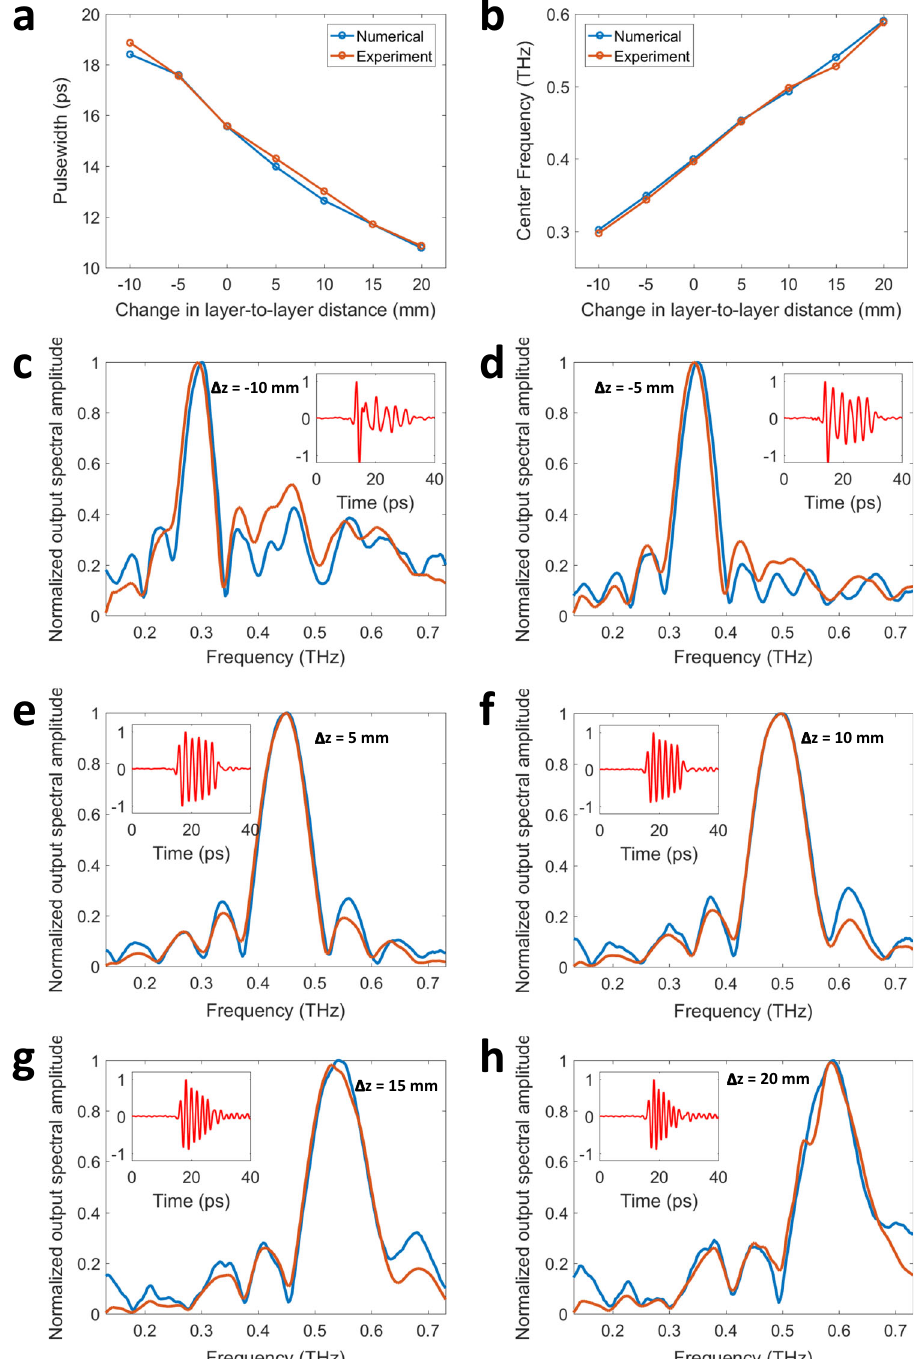
Fig. 4 Pulse width tunability of diffractive networks. a Numerically calculated and experimentally measured temporal pulse widths and ( b ) the corresponding shifts in the center frequency are depicted as a function of the inter-layer distances of a pulse shaping diffractive network that was originally trained for synthesizing a square pulse width of 15.50 ps ( Δ z = 0 mm, see Supplementary Fig. 5). c – h The numerically computed (blue) and the experimentally measured (orange) normalized spectral amplitudes, with the inset plots showing the experimentally measured temporal waveform (red) when the layer-to-layer distances are changed by ( c ) Δ z = − 10 mm, ( d ) Δ z = − 5 mm, ( e ) Δ z = 5 mm, ( f ) Δ z = 10 mm, ( g ) Δ z = 15 mm and ( h ) Δ z = 20 mm. The negative (positive) sign indicates that the inter-layer axial distances decrease